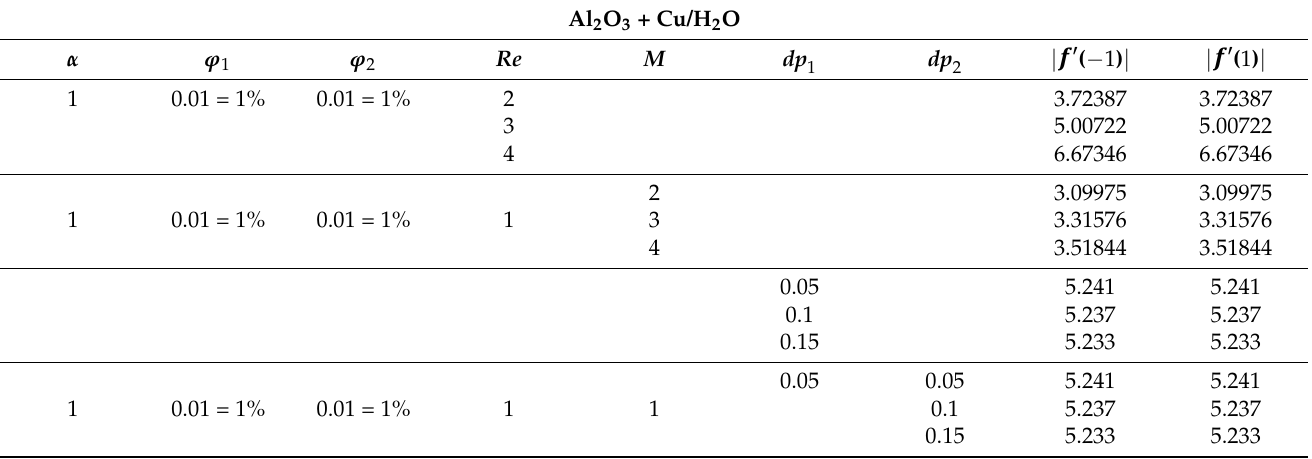
Table 4. Calculations of the effect of shear stress at the lower and upper disks for Al 2 O 3 + Cu/H 2 O 𝐻𝑁 (cid:3033)(cid:3031) for different nondimensional parameters.